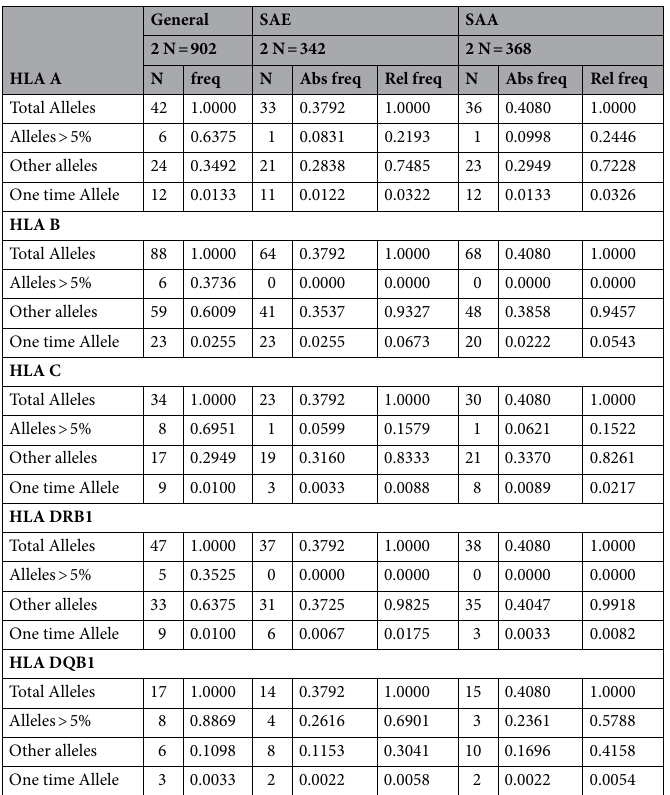
Table 1. Summary of allele frequency for all loci. For the General population (451 UCB units, 902 alleles) N: Number of alleles present, Freq: frequency. For SAE and SAA populations (171 UCB units, 342 alleles and 184 UCB units, 368 alleles respectively) N: Number of alleles present, Abs Freq: absolute frequency, Rel Freq: relative frequency within the